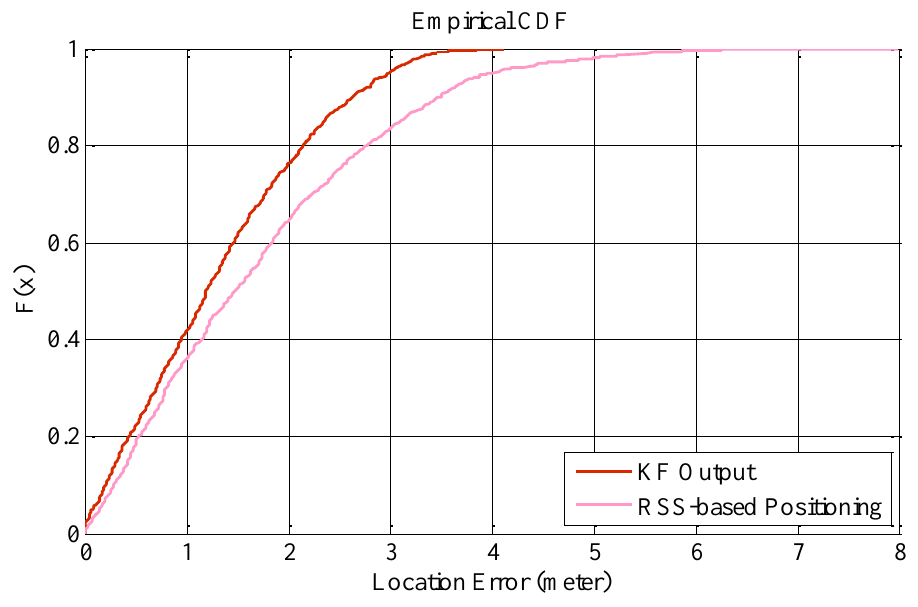
Figure 6. Empirical CDF comparison of Kalman filter output and RSSI-based